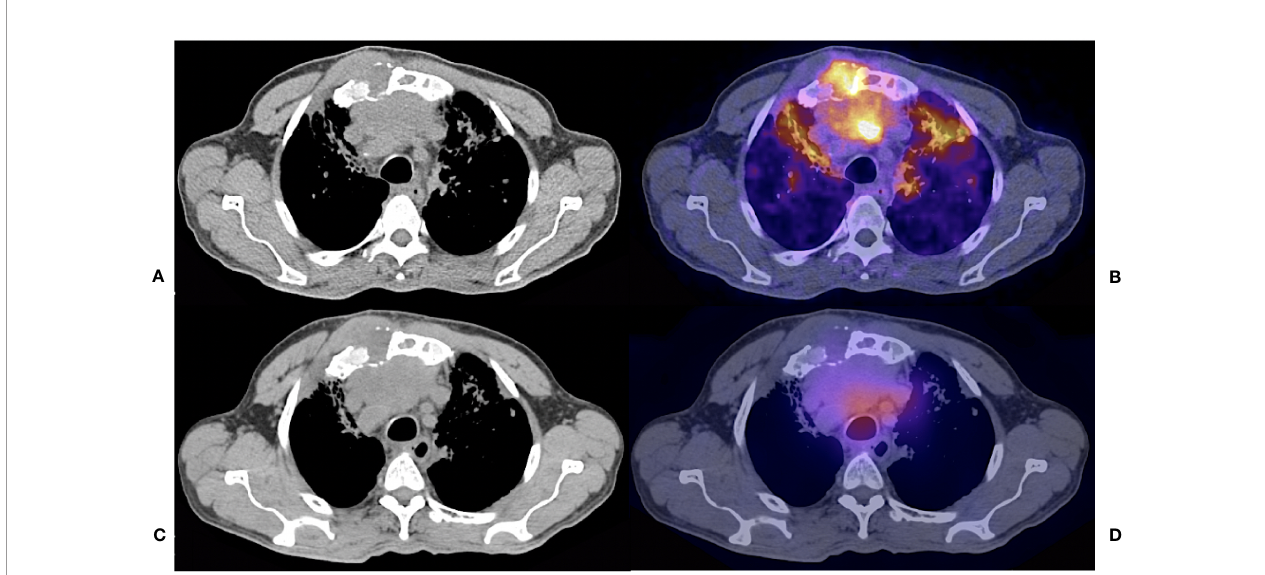
FIGURE 2 | 61 years old female with follicular thyroid carcinoma, insular differentiation (20%), treated with TT + RAI (cumulative dose 25900 MBq); Thyroglobulin 3922 ng/dl. Fused hybrid and simple CT thoracic images shows a Iytic lesion in sternum with soft tissue component and prevascular conglomerate. (A) CT acquired for PET